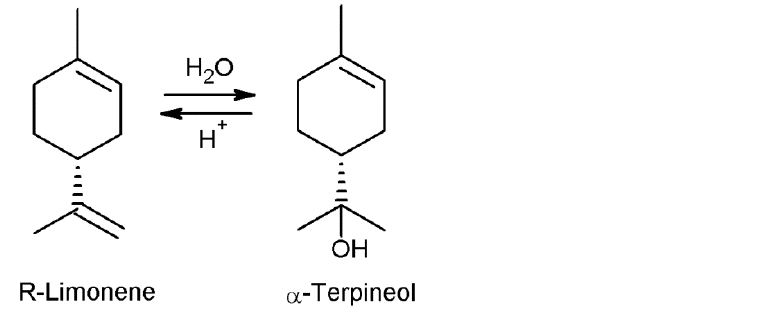
Figure 7. ( a ) Differential pulse voltammograms recorded with the Fe(TPFPP)Cl/AuNPs-S-Gr sensor